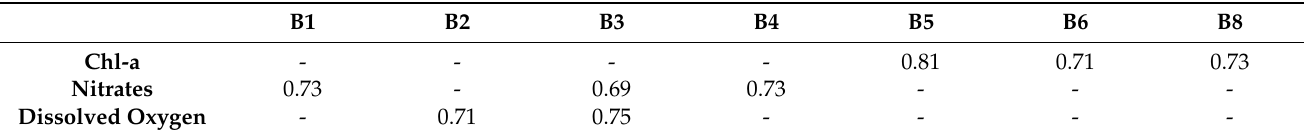
Table 4. Correlation between satellite bands and water quality parameters.